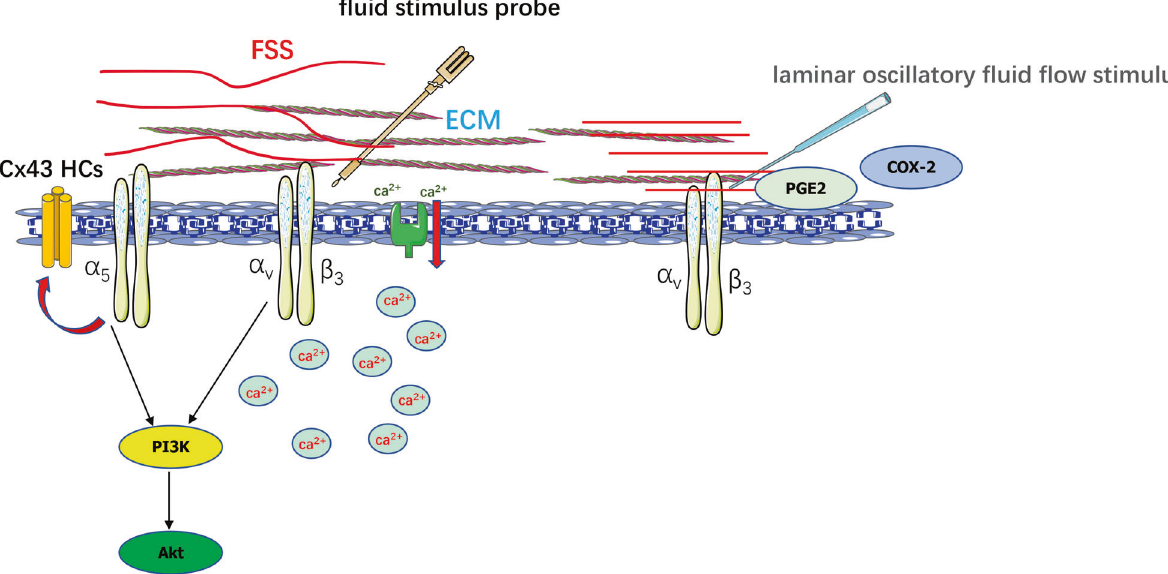
Fig. 3 Exogenous FSS stimulates integrins to regulate osteocyte activity. Integrin α V β 3 promotes Ca 2 + signaling pathway diffusion, activates PI3K/Akt signal pathway, and increases the generation of anabolic factors. FSS stimulates α 5 integrin and activates Cx43